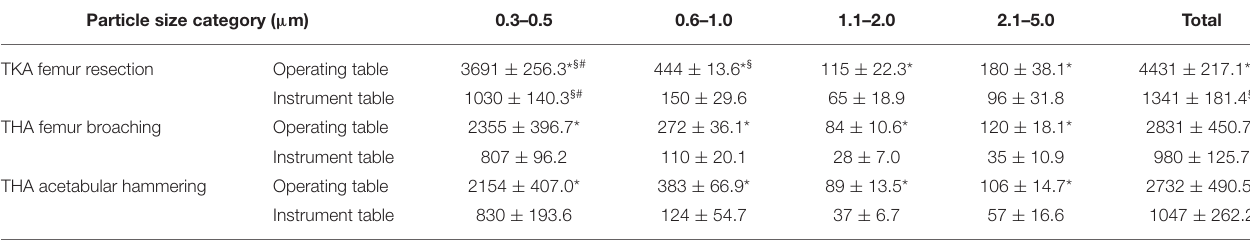
TABLE 1 | Mean number and standard deviation of airborne particles (particles/2.83L). Particle size category ( µ